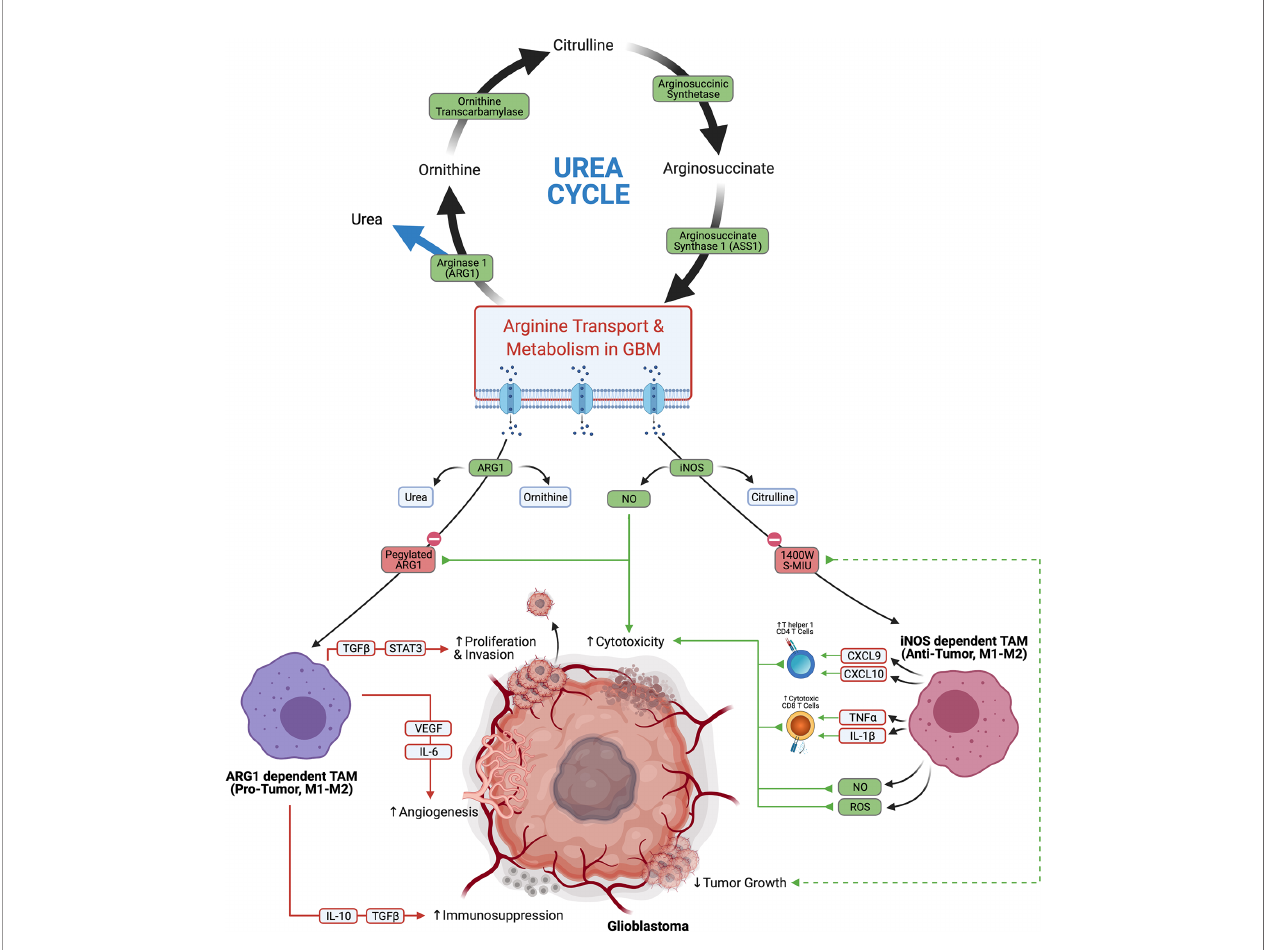
FIGURE 4 | Glioblastoma arginine metabolism via iNOS or Arg1 polarizes the tumor associated macrophages towards anti-tumor tumor or pro-tumor phenotypes,